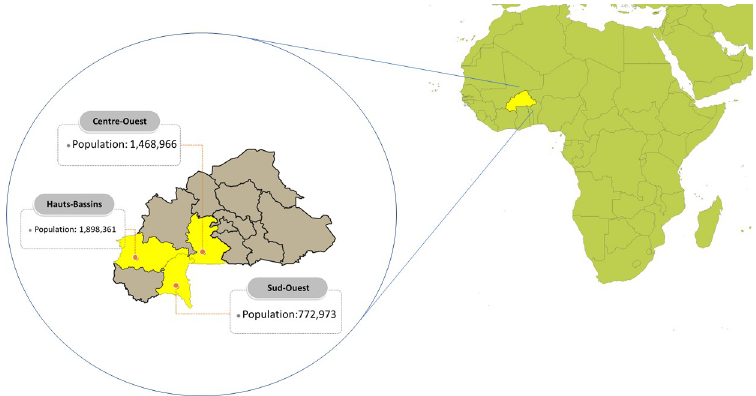
Fig 1. The three regions of Burkina Faso included in this study. This map was compiled using base-layer maps from “https://www.naturalearthdata.com/downloads/10m-cultural-vectors/10m-admin-0-countries” and “https:// datacatalog.worldbank.org/dataset/burkina-faso-administrative-boundaries-2017”.